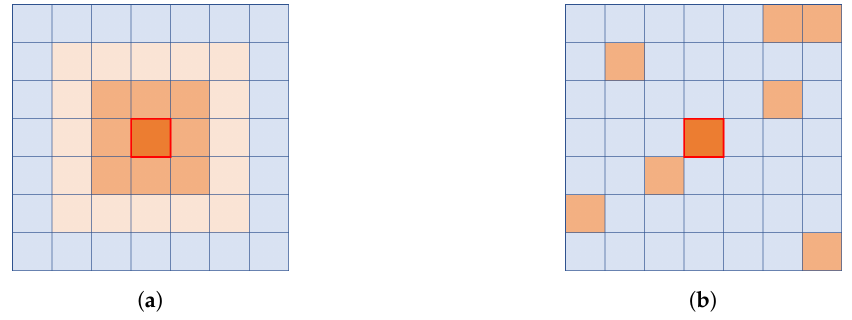
Figure 5. Cell neighborhood. ( a ) static neighborhood (CS + S); ( b ) dynamic neighborhood (CS +